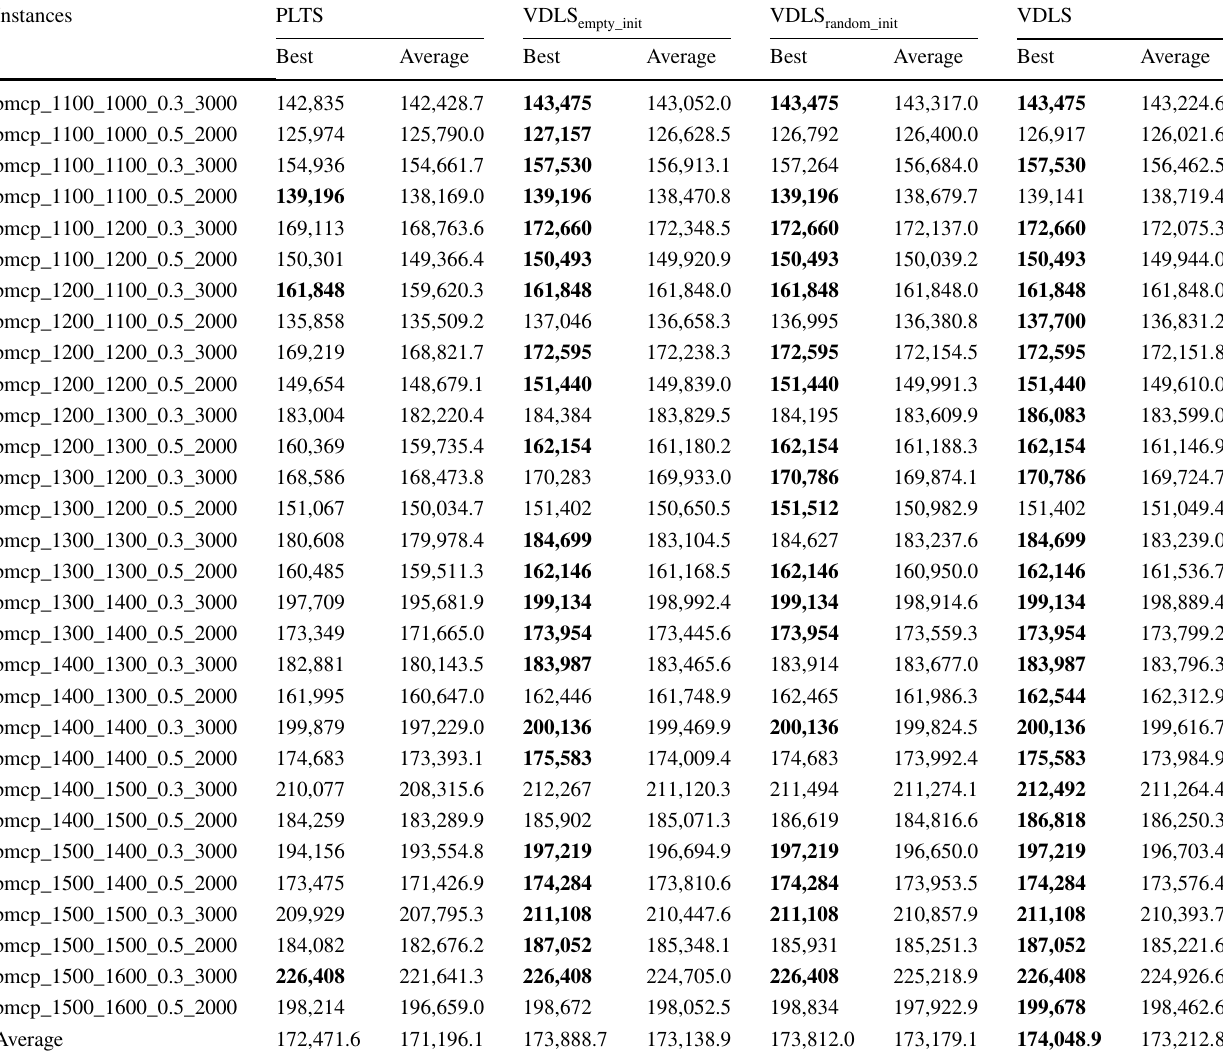
Table 10 Comparison of the VDLS and its variant algorithms, VDLS empty_init and VDLS random_init , as well as the PLTS algorithm, with 30 min of time limit in solving the 30 instances of the second set